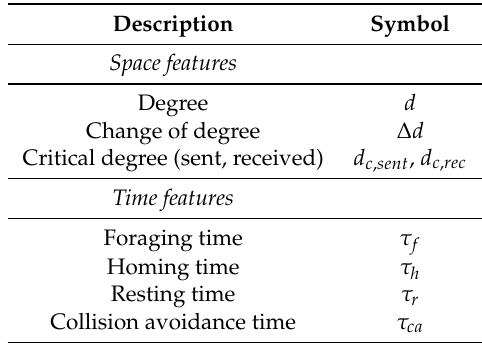
Table 2. An overview of the investigated space and time